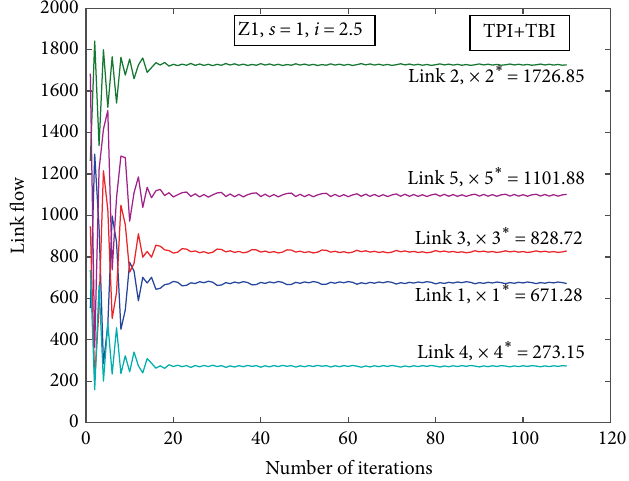
Figure 5: Convergence curves of total link flows of TPI & TBI (Z1,